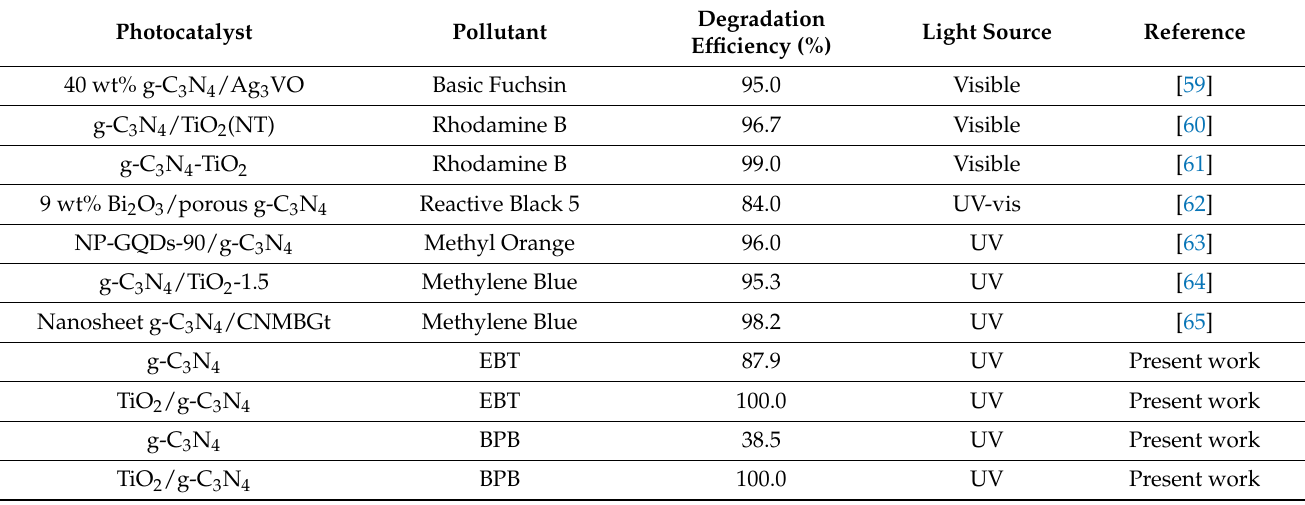
Table 2. Comparison of photocatalytic activity of g-C 3 N 4 based photocatalysts.